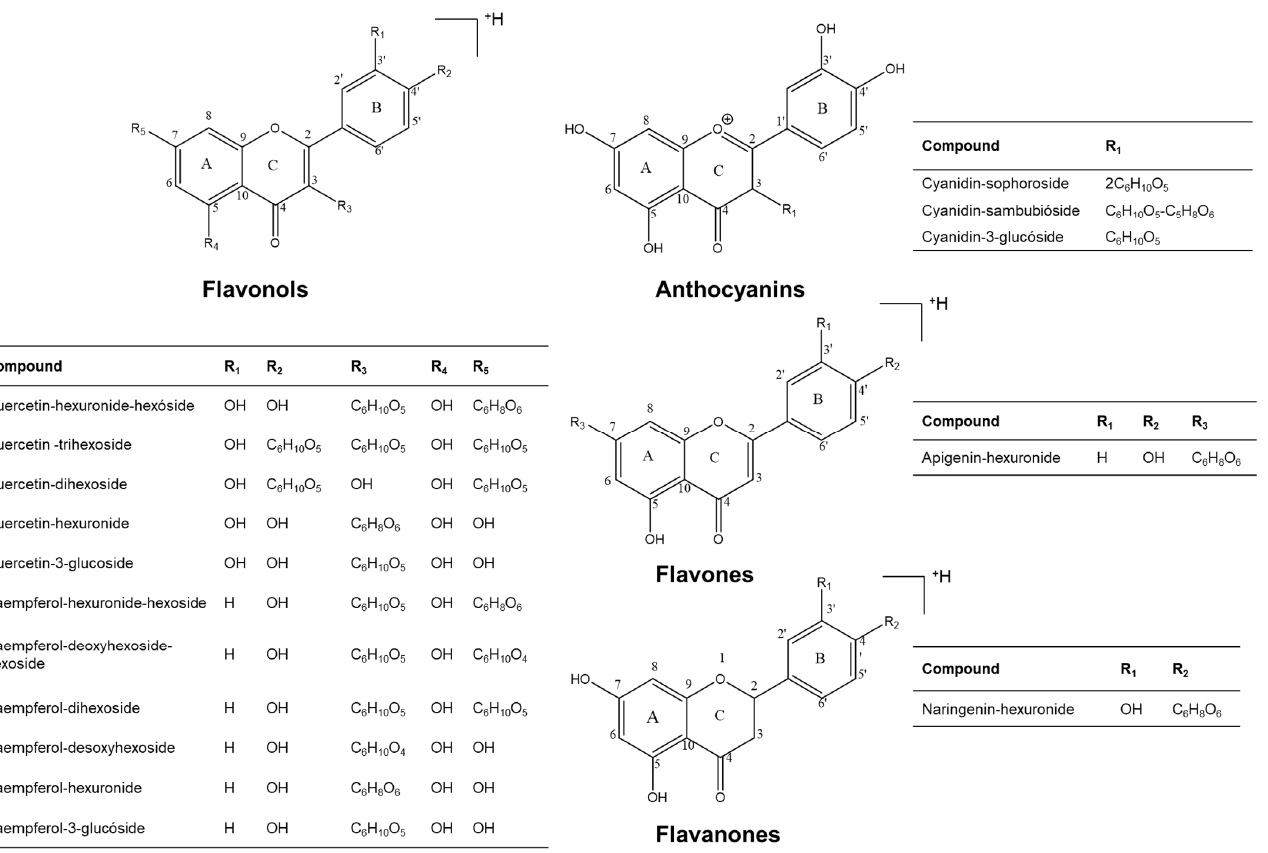
Figure 3. Chemical structures of flavonols, anthocyanins, flavones and flavanones detected in the H . rosa ‐ sinensis flower extracts studied in this work.